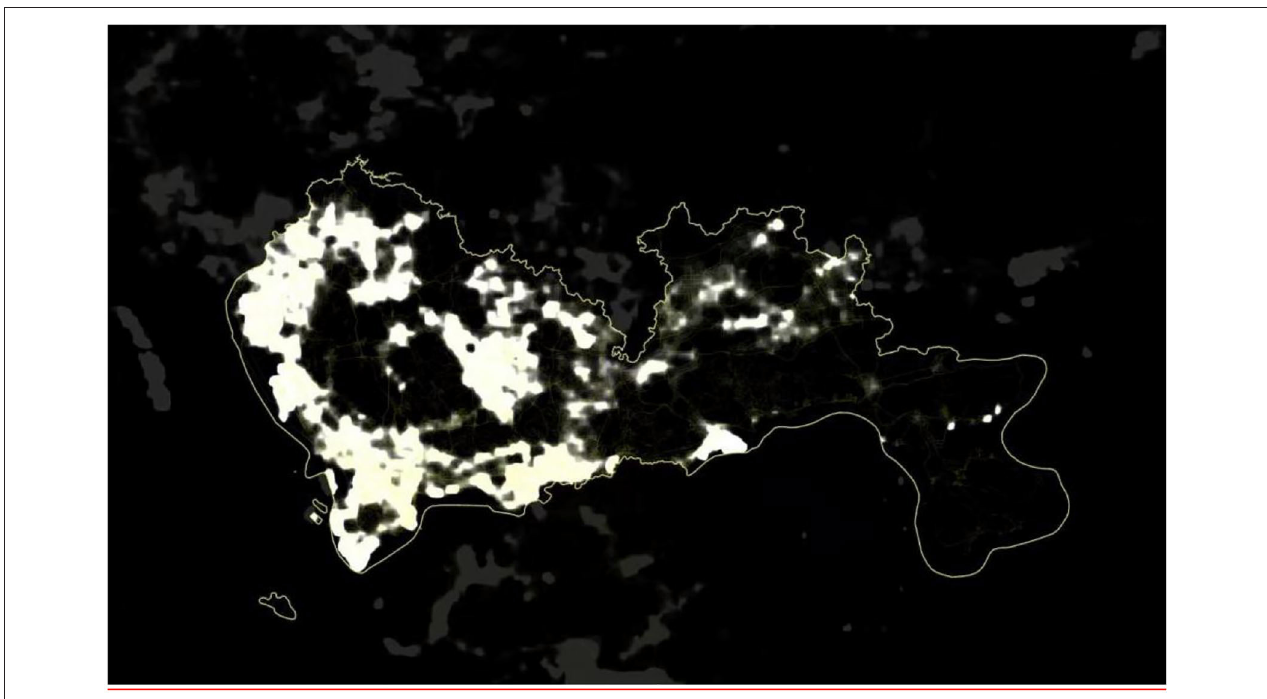
FIGURE 7 | Shenzhen night light distribution map (image source: drawn by the author with GIS